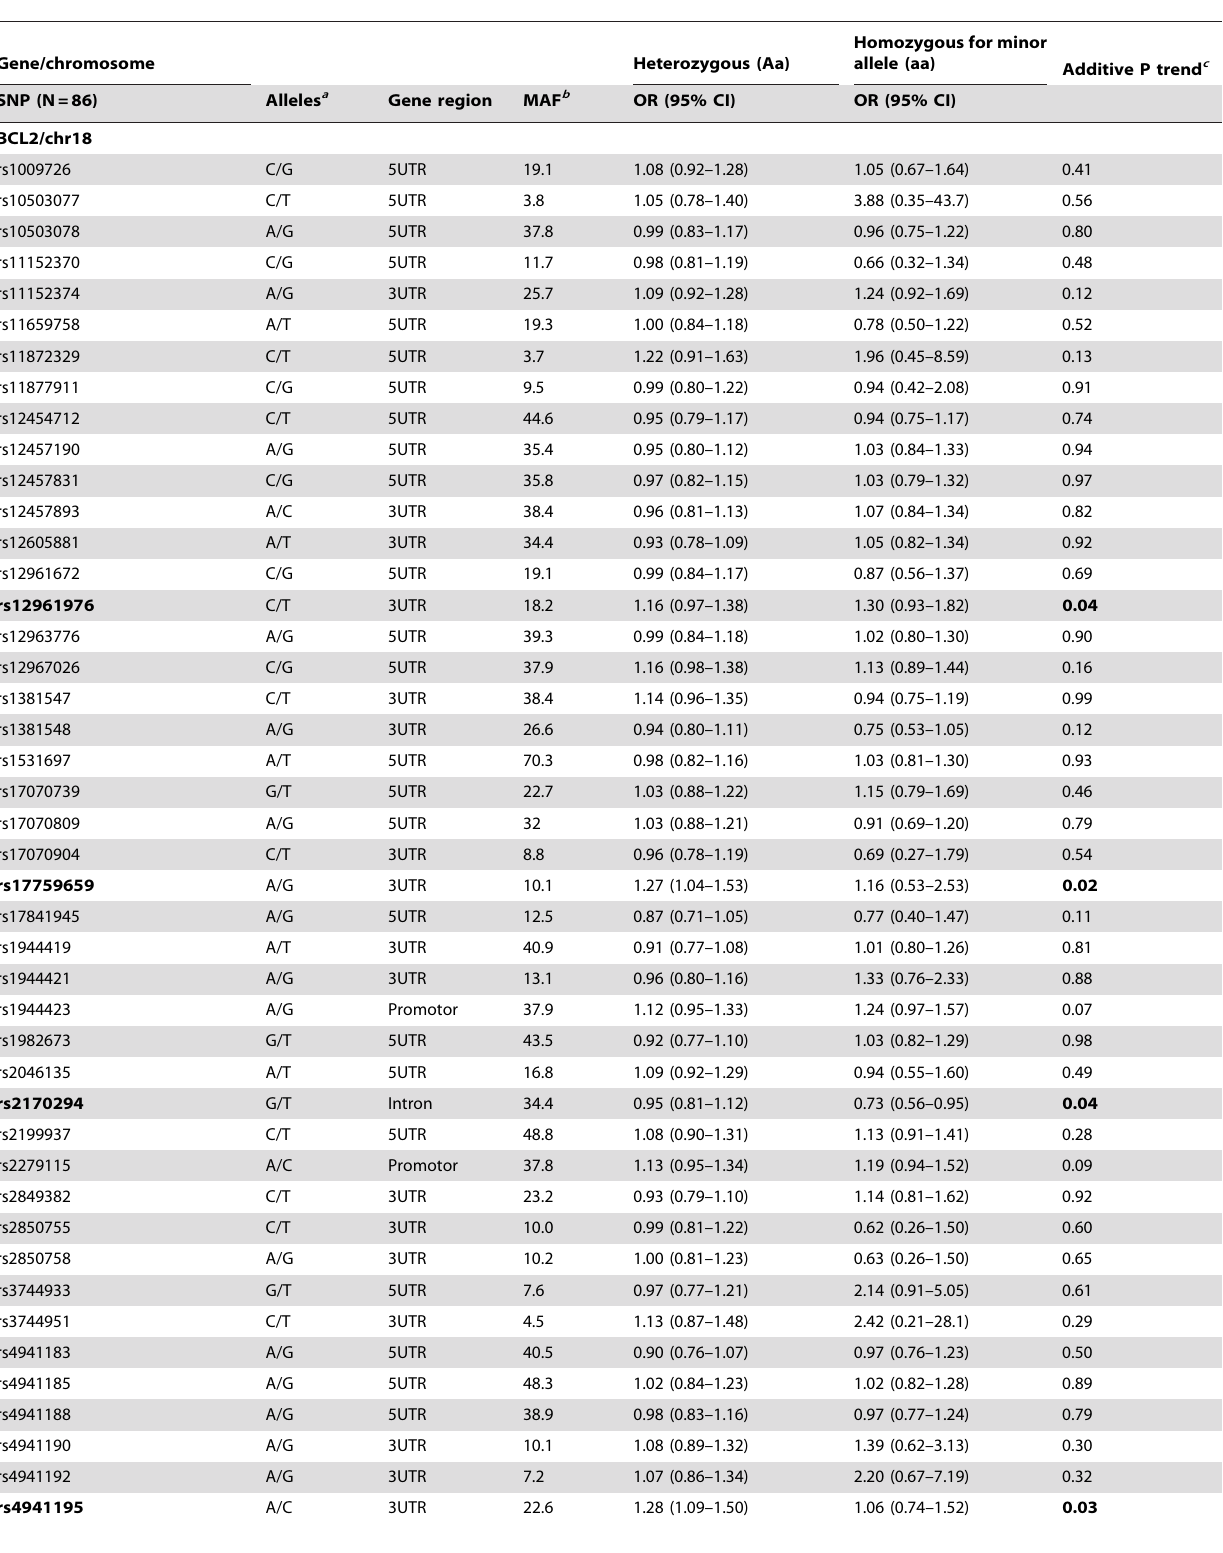
Table 3. Association of genetic variants in BCL-2-family genes with endometrial cancer risk among 1,028 cases and 1,922 controls, the Shanghai Endometrial Cancer Genetics Study